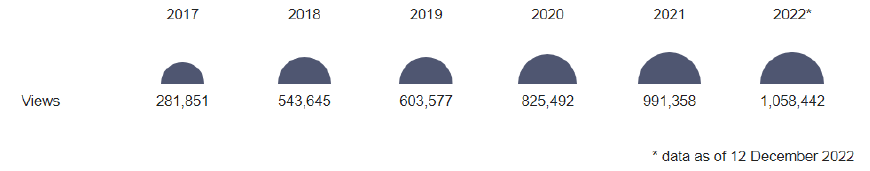
Figure 1. Article views per year trend.